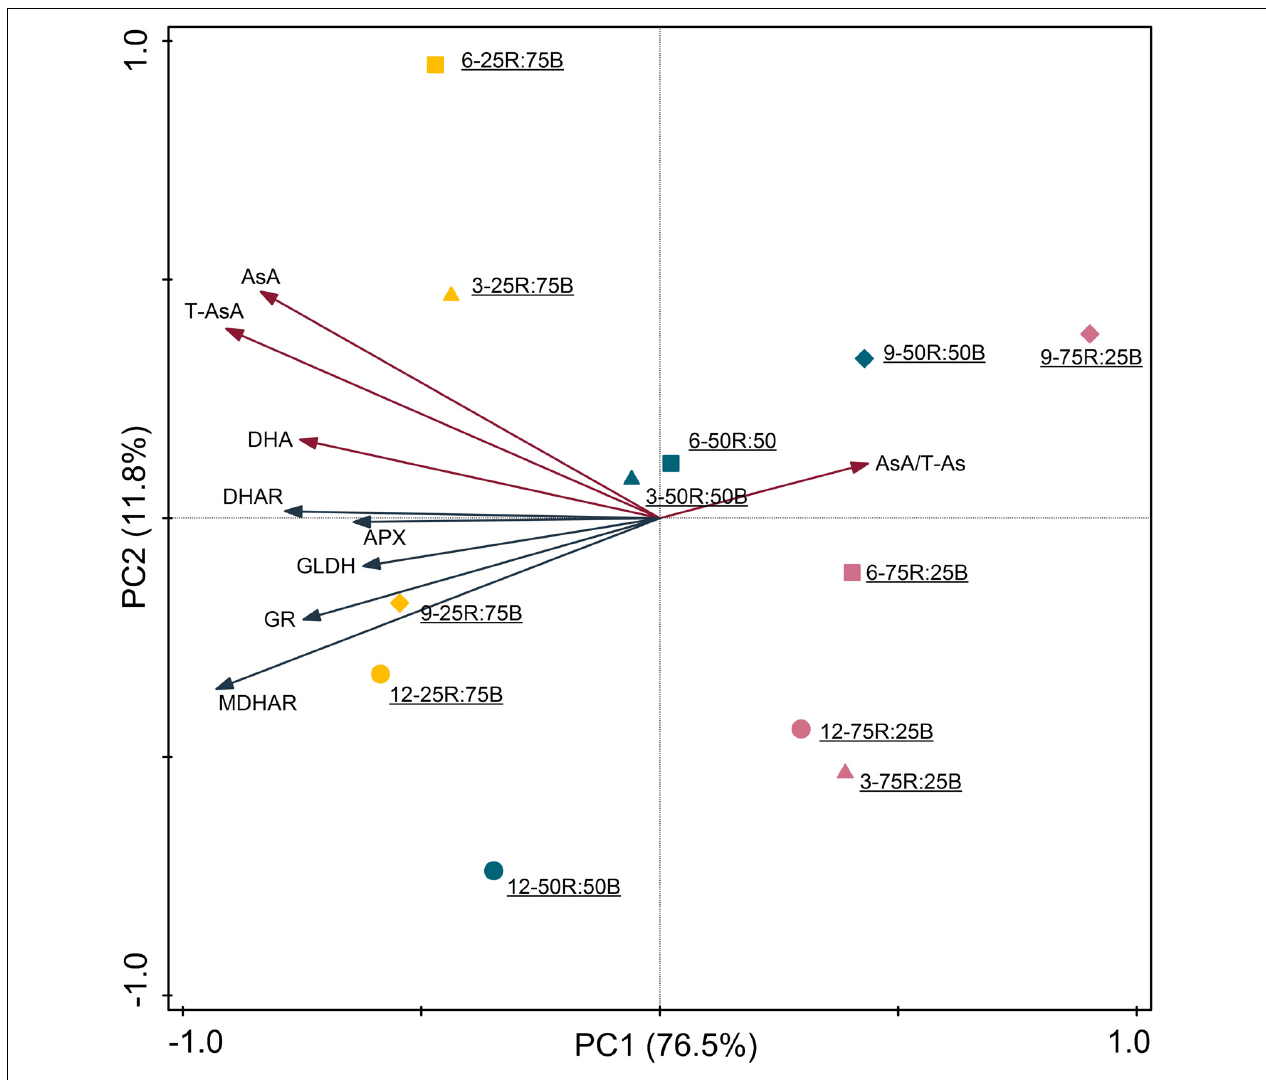
FIGURE 6 | Principal component analysis of AsA pool sizes and enzyme activities in lettuce leaves under continuous light of different red:blue ratios (yellow symbol-25R:75B; blue symbol-50R:50B; red symbol-75R:25B) on different days ( (cid:52) –day 3; components (PC1,2) of the measured network topological